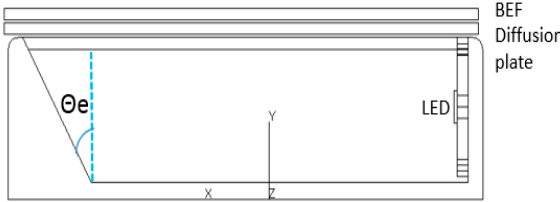
Figure 6. Lateral section of the light guide module that show a tilting end wall at an angle of 𝚯 𝐞 .